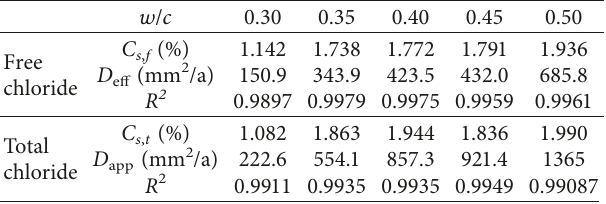
s ), chloride diffusion co-